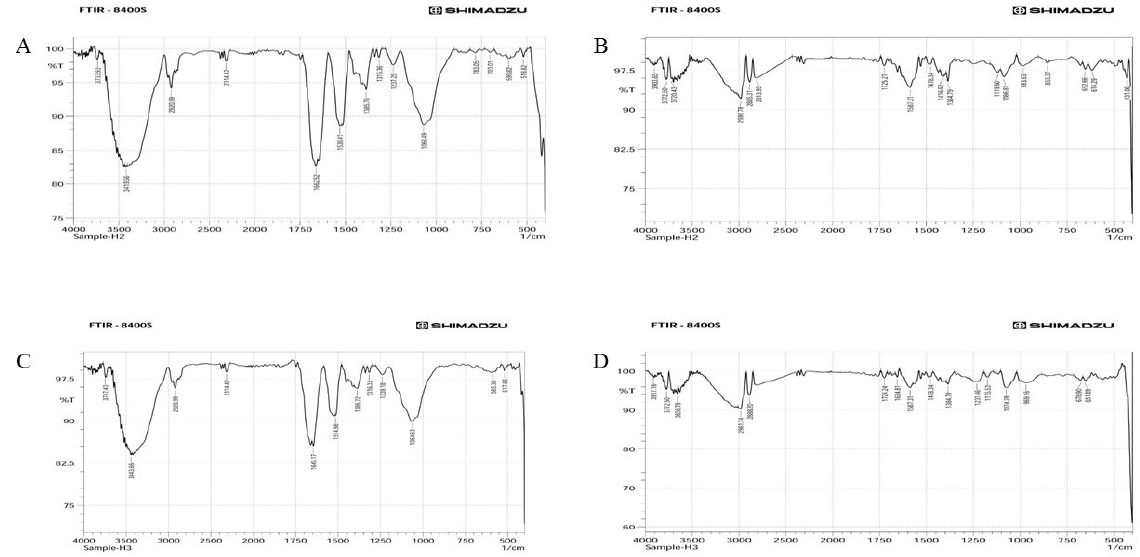
Figure 4. FT-IR spectra of ( A ) Pantoea stewartii -synthesized silver nanoparticles, ( B ) pellet of Pantoea stewartii , ( C ) Priestia aryabhattai -synthesized silver nanoparticles, and ( D ) pellet of Priestia aryabhattai .